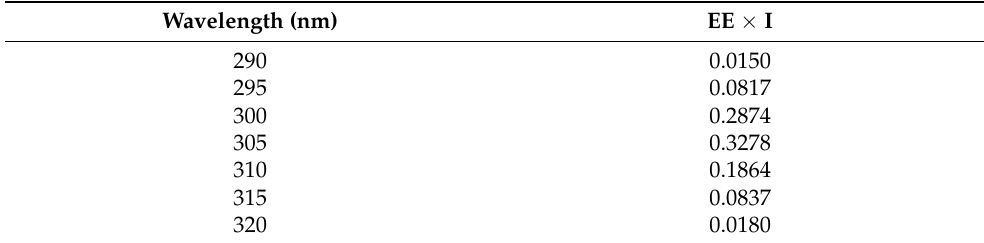
Table 4. E ( λ ) and I ( λ ) values used for SPF